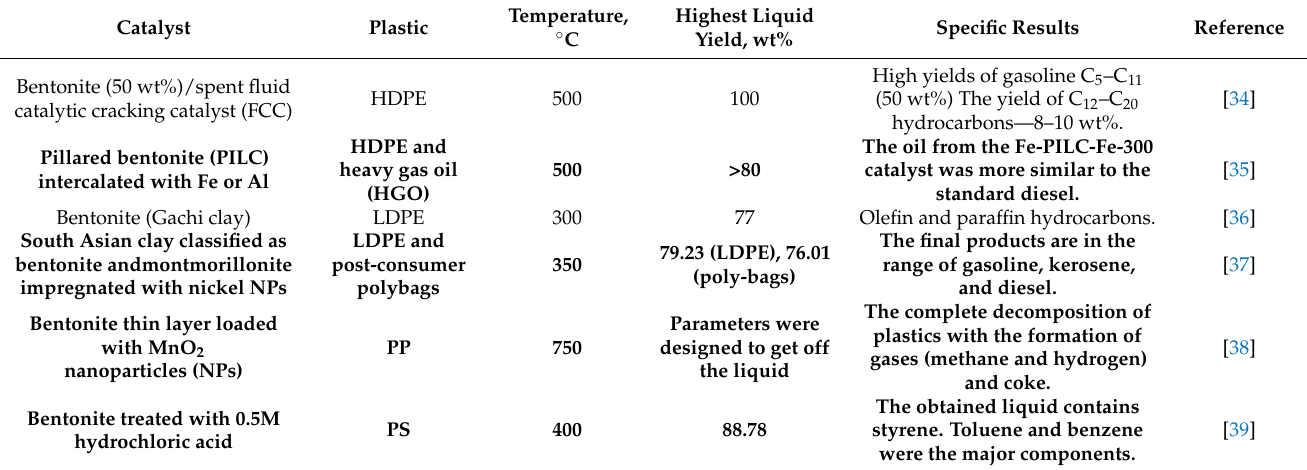
Table 2. Publications on the conversion of different plastics over clay minerals from smectite group